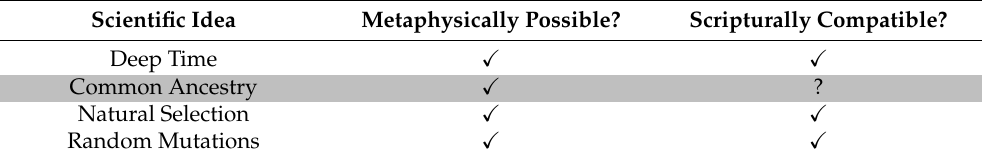
Table 1. Evaluation of Neo-Darwinism.